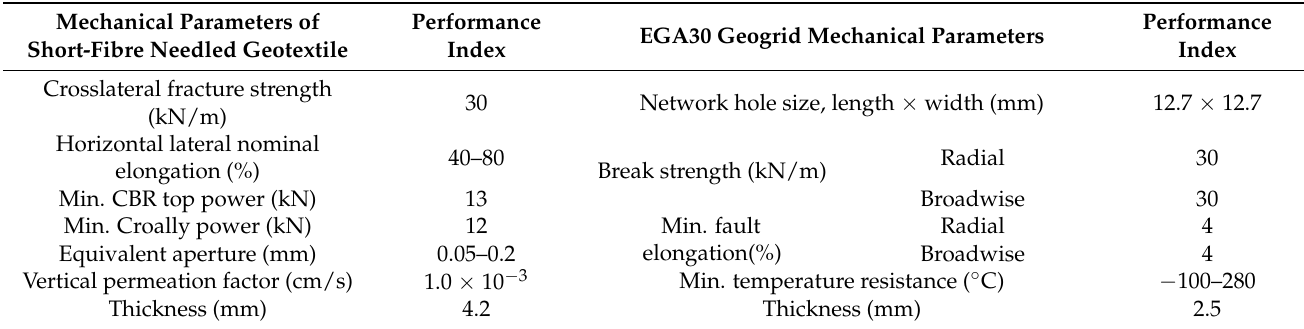
Table 2. Performance parameters of geosynthetics.